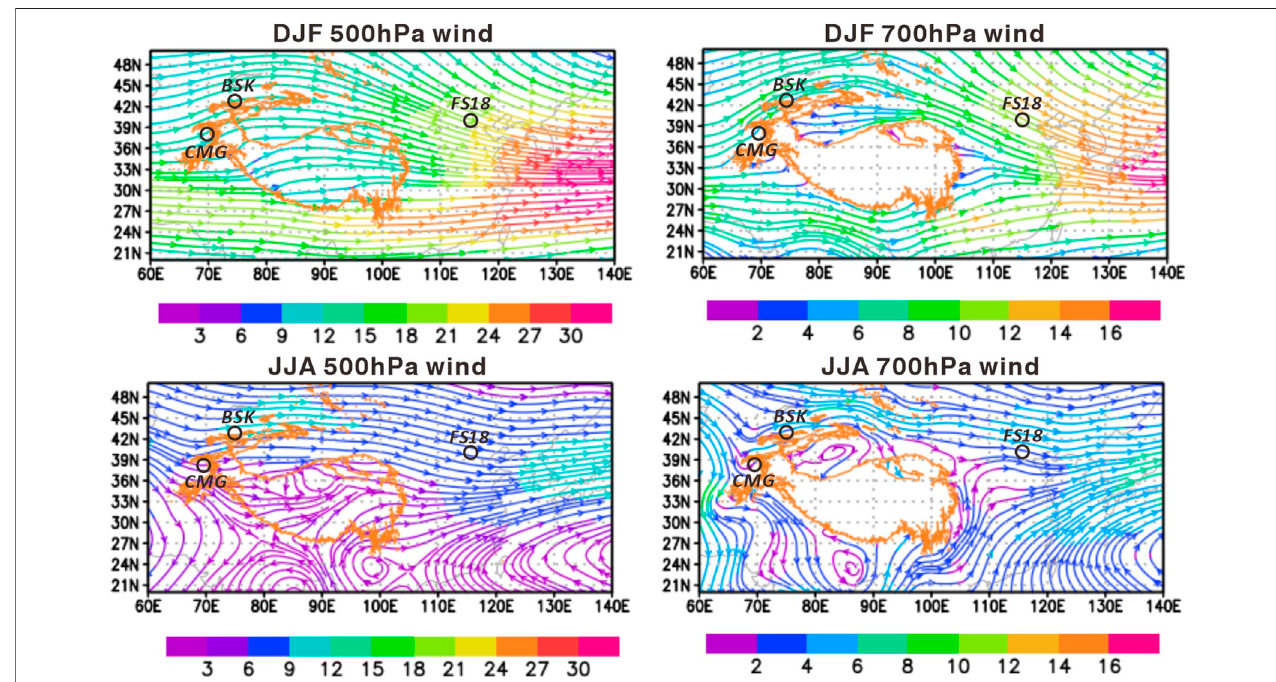
FIGURE 2 | Mean winter and summer streamlines (m s − 1 ) at 500 hPa (~5,000 m.a.s.l.) and 700 hPa (~3,000 m.a.s.l.) for 1980 – 2016 across East and Central Asia (URL: https://gmao.gsfc.nasa.gov/reanalysis/MERRA-2/). The orange lines represent the 1,700 m isohypse lines.